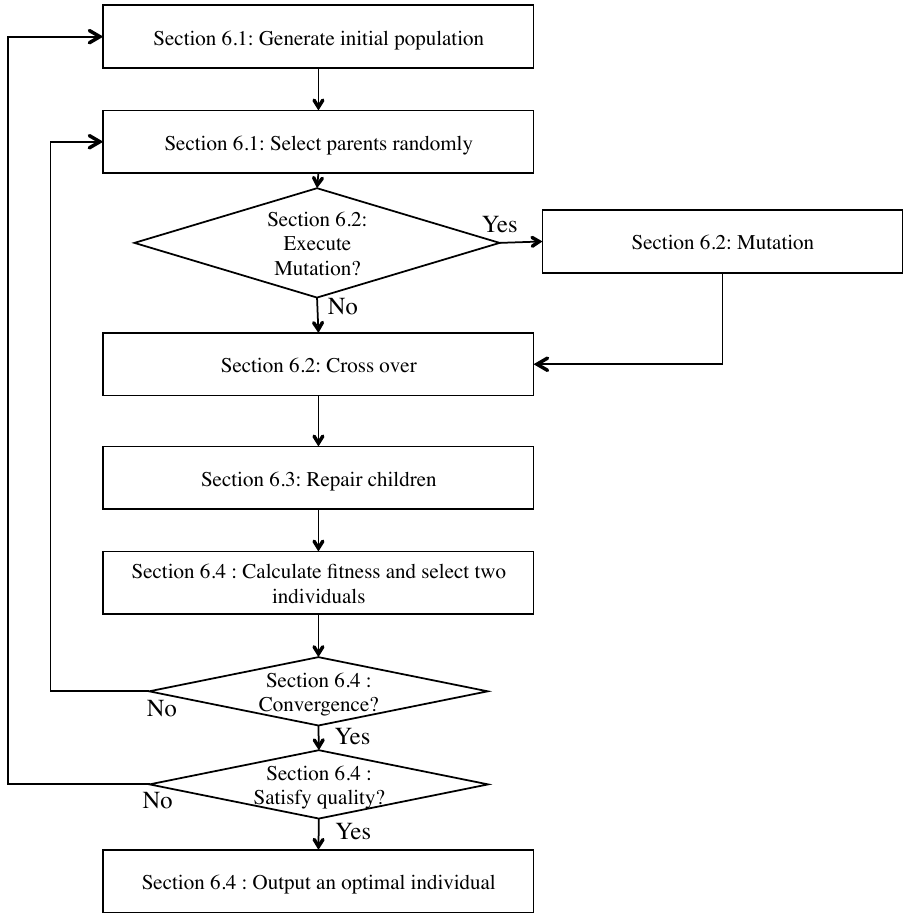
Figure 6. Flowchart of our Genetic Algorithm (GA)-based slot assignment